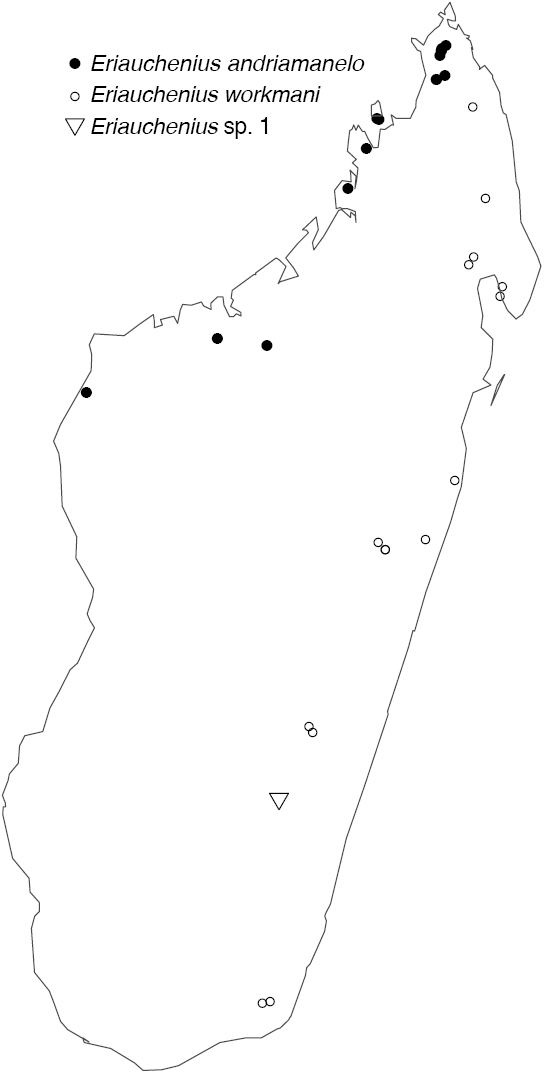
Distribution map for Eriauchenius species.